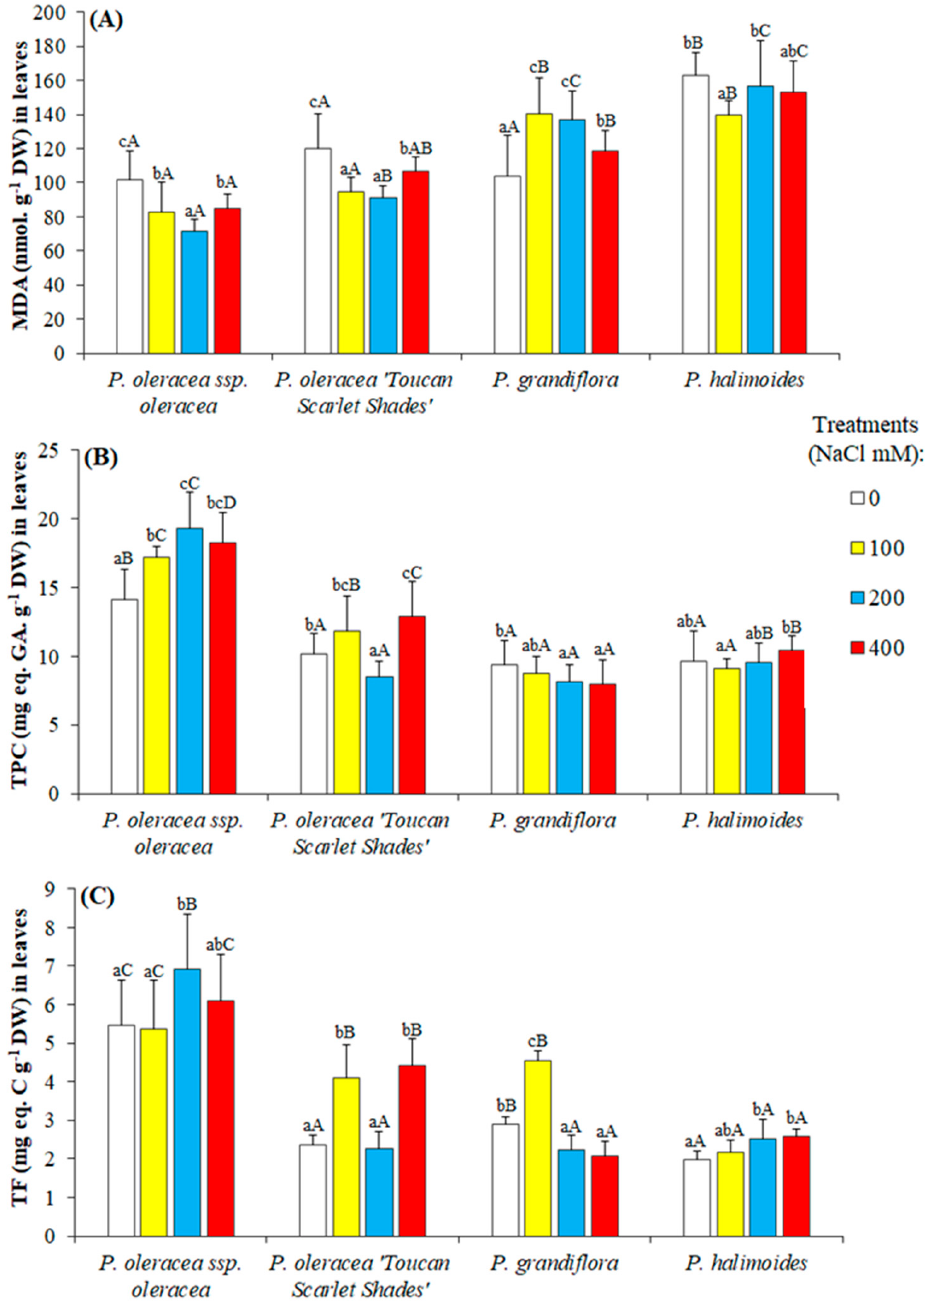
Figure 5. Malondialdehyde (MDA) and chemical antioxidants accumulation in the leaves of Portulaca genotypes after 5 weeks of salt stress treatments. ( A ) MDA, ( B ) total phenolic compounds (TPC), and ( C ) total flavonoids (TF). The values shown are means ± SE ( n = 5). Different lowercase letters above the bars indicate significant differences between the control plants, and different capital letters indicate significant differences between different genotypes.